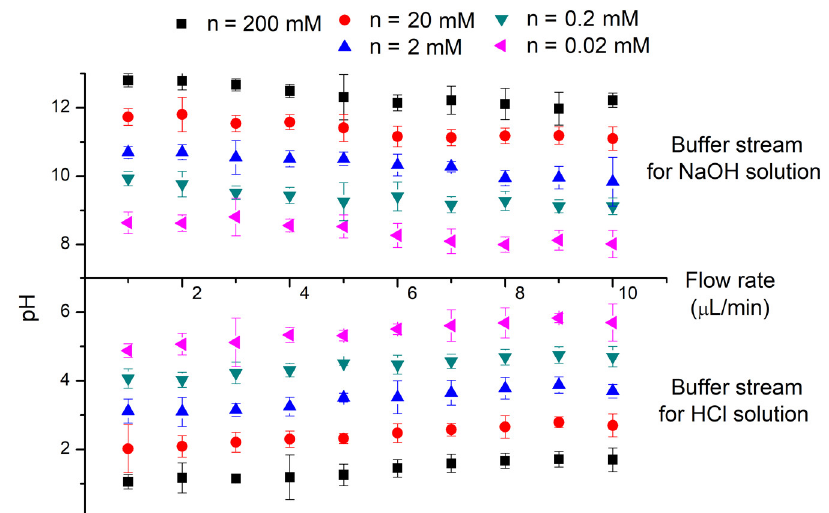
Figure 5. Experimentally tested pH values of flowing out buffer streams along the diffusion channel. Buffer streams (water) are pumped into a 5 mm diffusion channel with solution streams (HCl or NaOH solutions). Different concentrations of HCl and NaOH are tested under various flow rates. The width of diffusion channel is 100 µ m. The volumetric flow rates for two laminar streams range from 1 µ L · min − 1 to 10 µ L · min − 1 . The presented experimental results are averaged from five tests.